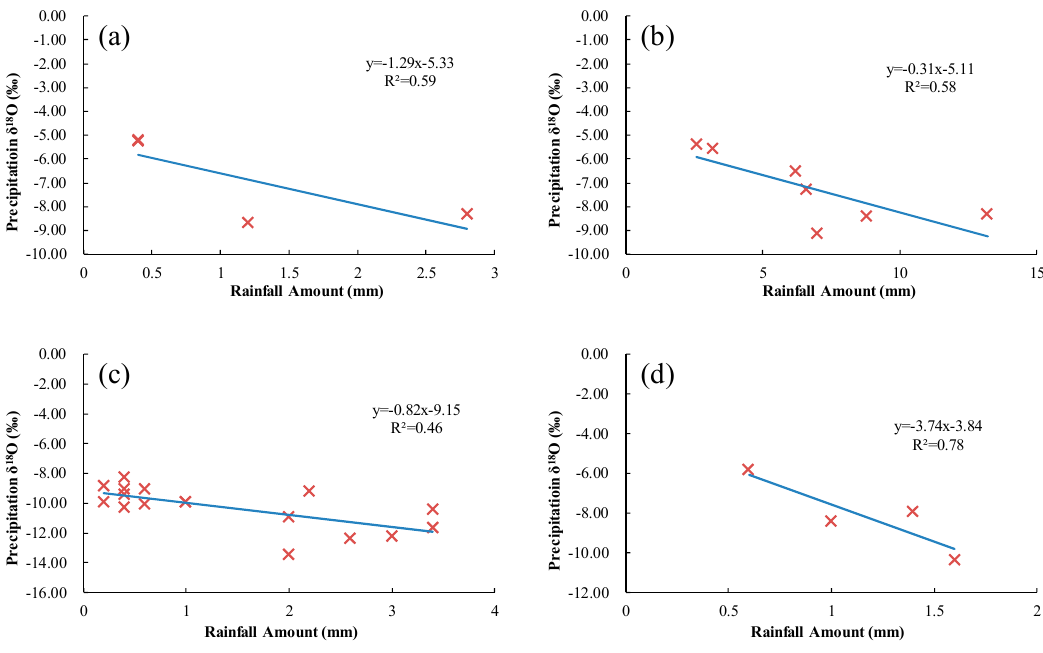
Figure 3. The relationship between rainfall amount and precipitation δ 18 O. Figure ( a – d ) represents event 3, 4, 5 and 6, respectively (represents rainfall amount in one hour and its isotopic value).